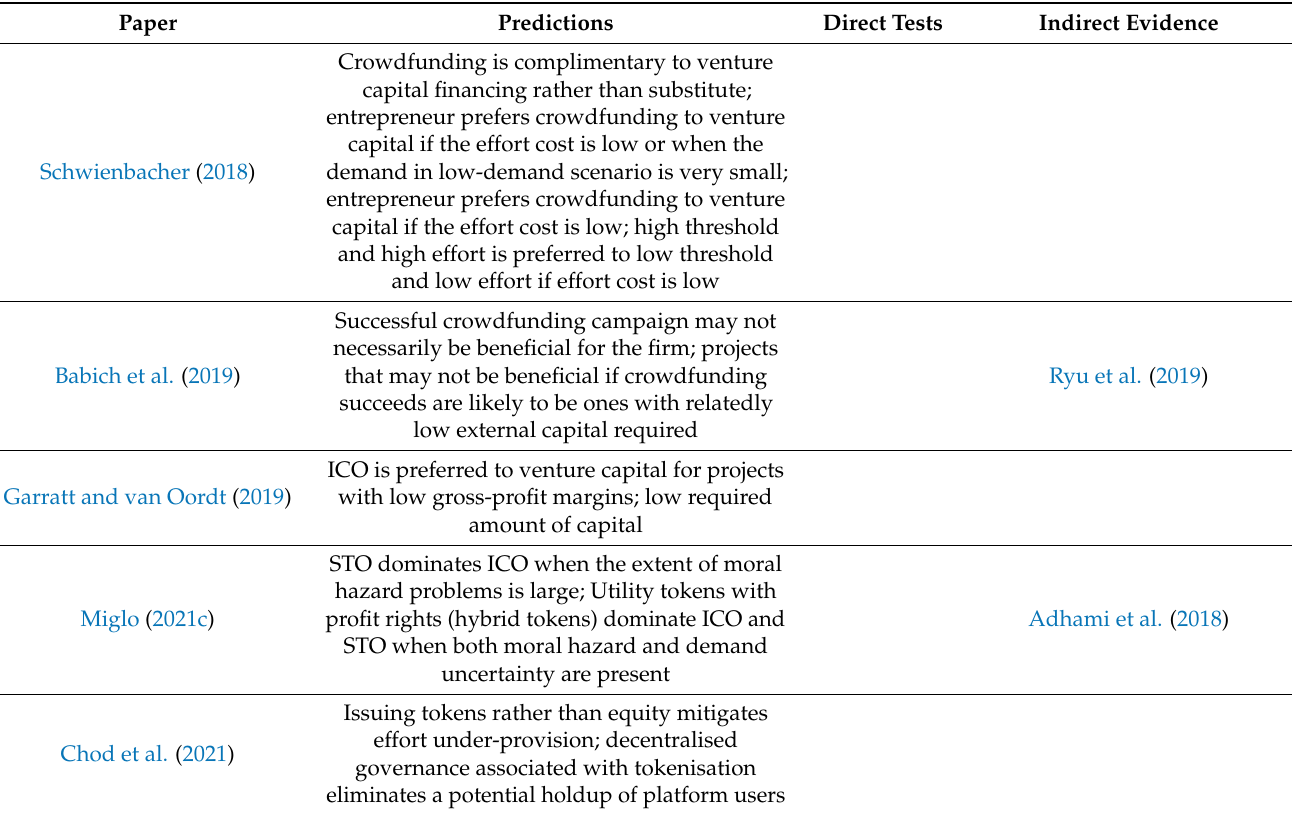
Table 6. Moral hazard-based theories of crowdfunding and token